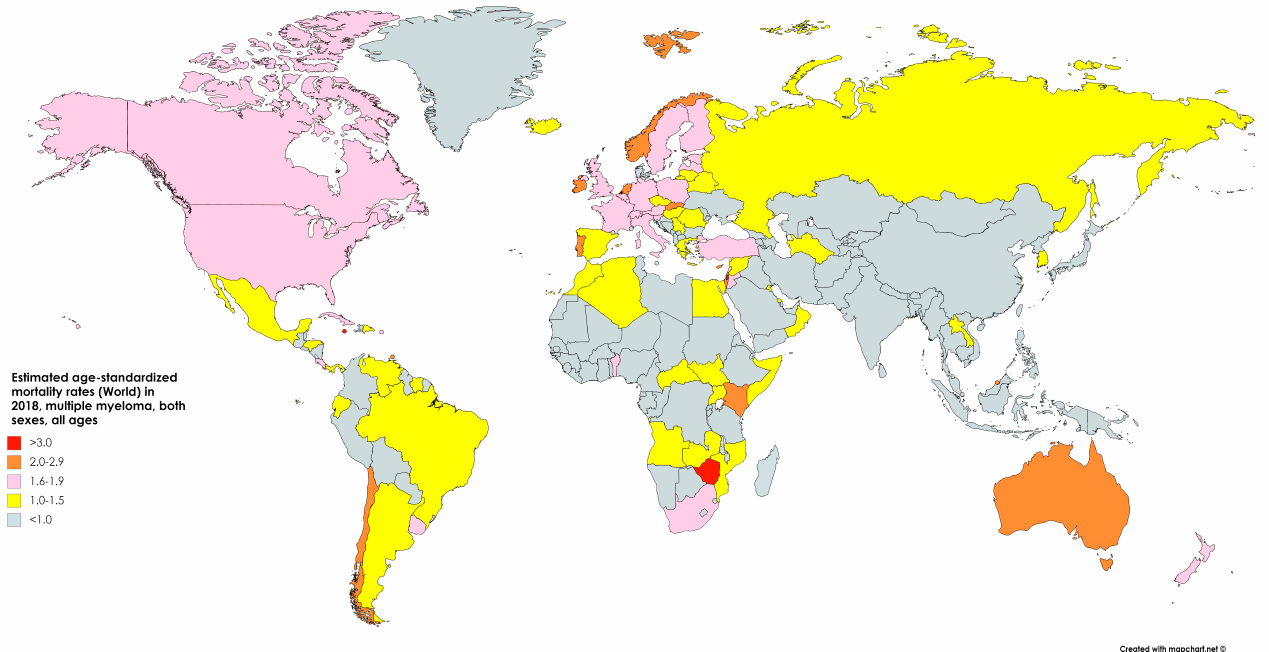
Figure 2. Map showing the estimated age-standardized mortality rates per 100,000 (world) in 2018 of multiple myeloma for both sexes and all ages. Created with mapchart.net. Data obtained from GLOBOCAN 2018 [7].